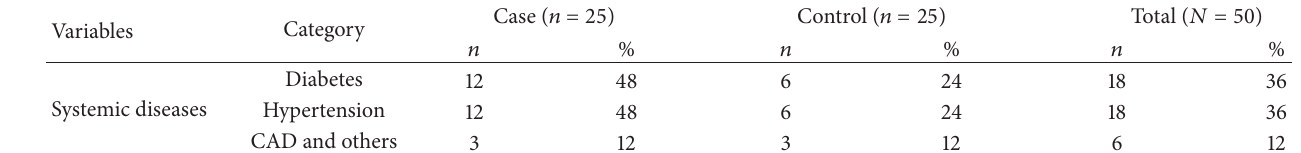
Table 4: Presence of associated clinical illnesses.